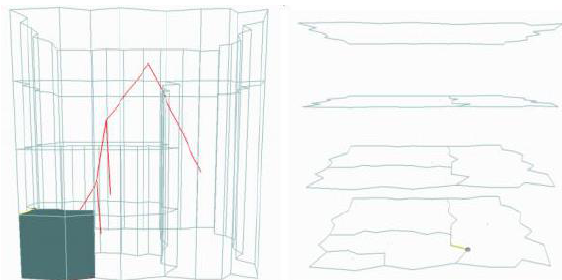
Figure 7. Accesssing n-LoD with dual graph (Karim and et al., 2016)